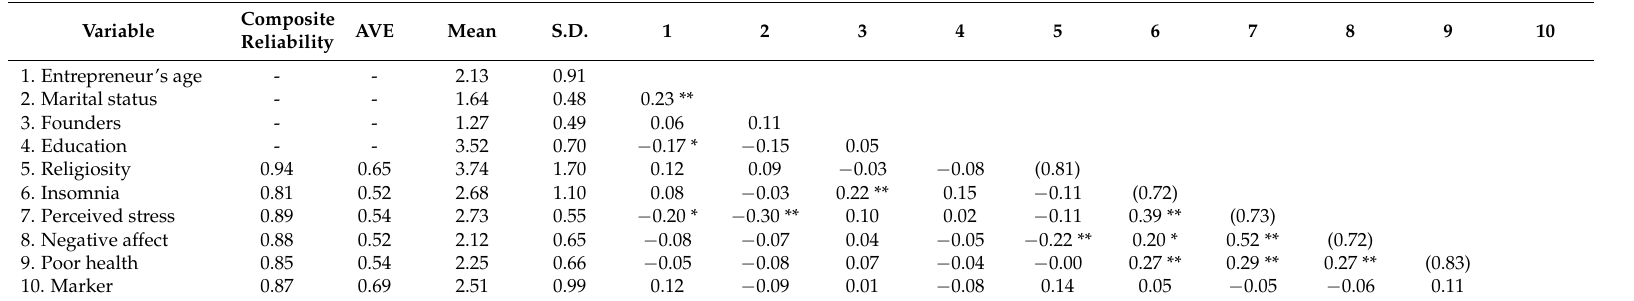
Table 1. Means, Standard Deviations, and